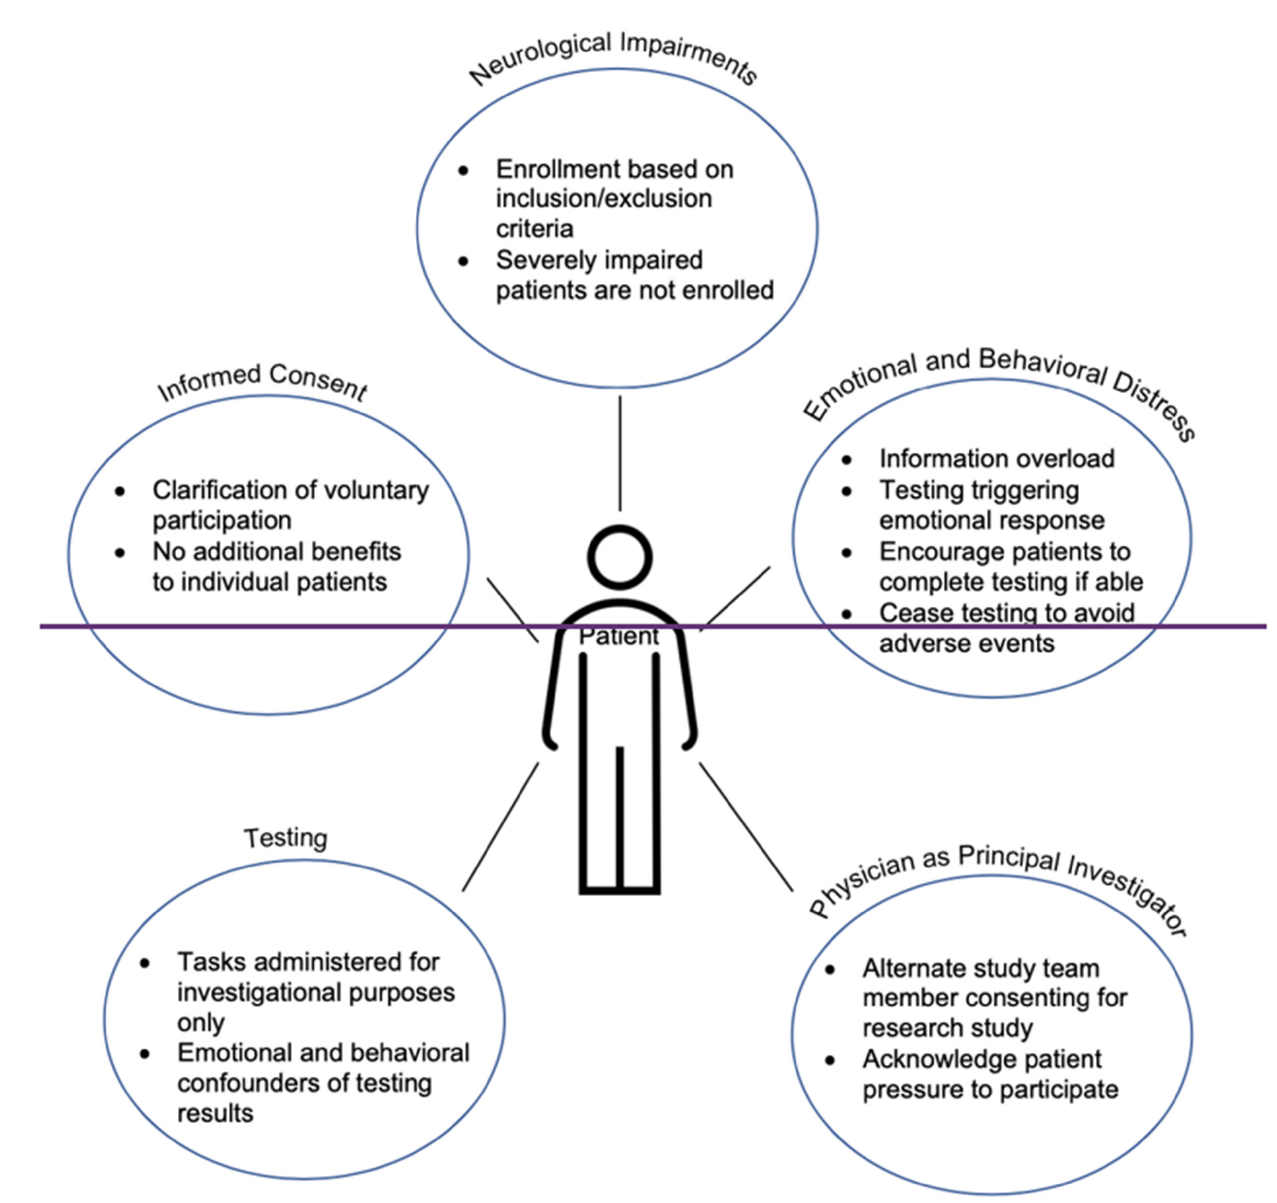
Figure 2. Summary of non-clinical research testing in the neuro-oncology setting.